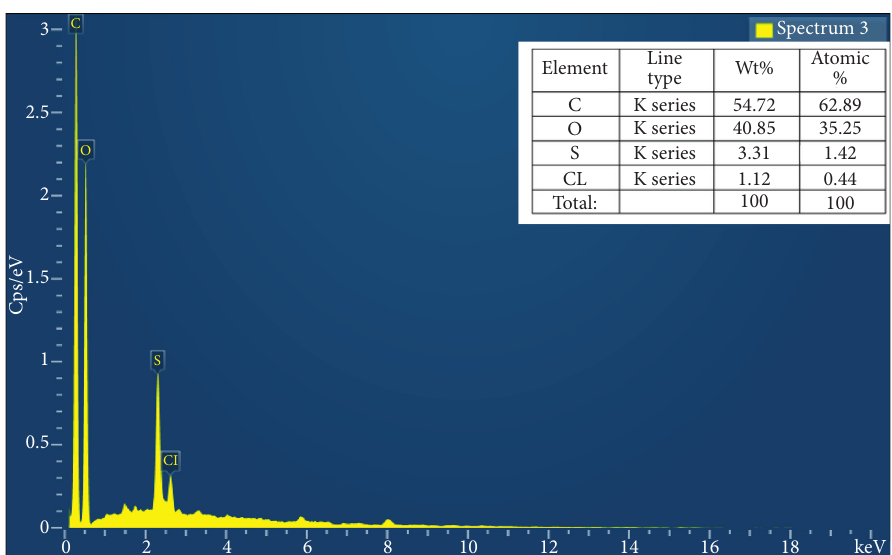
Figure 9: Elemental composition of GO using EDAX.